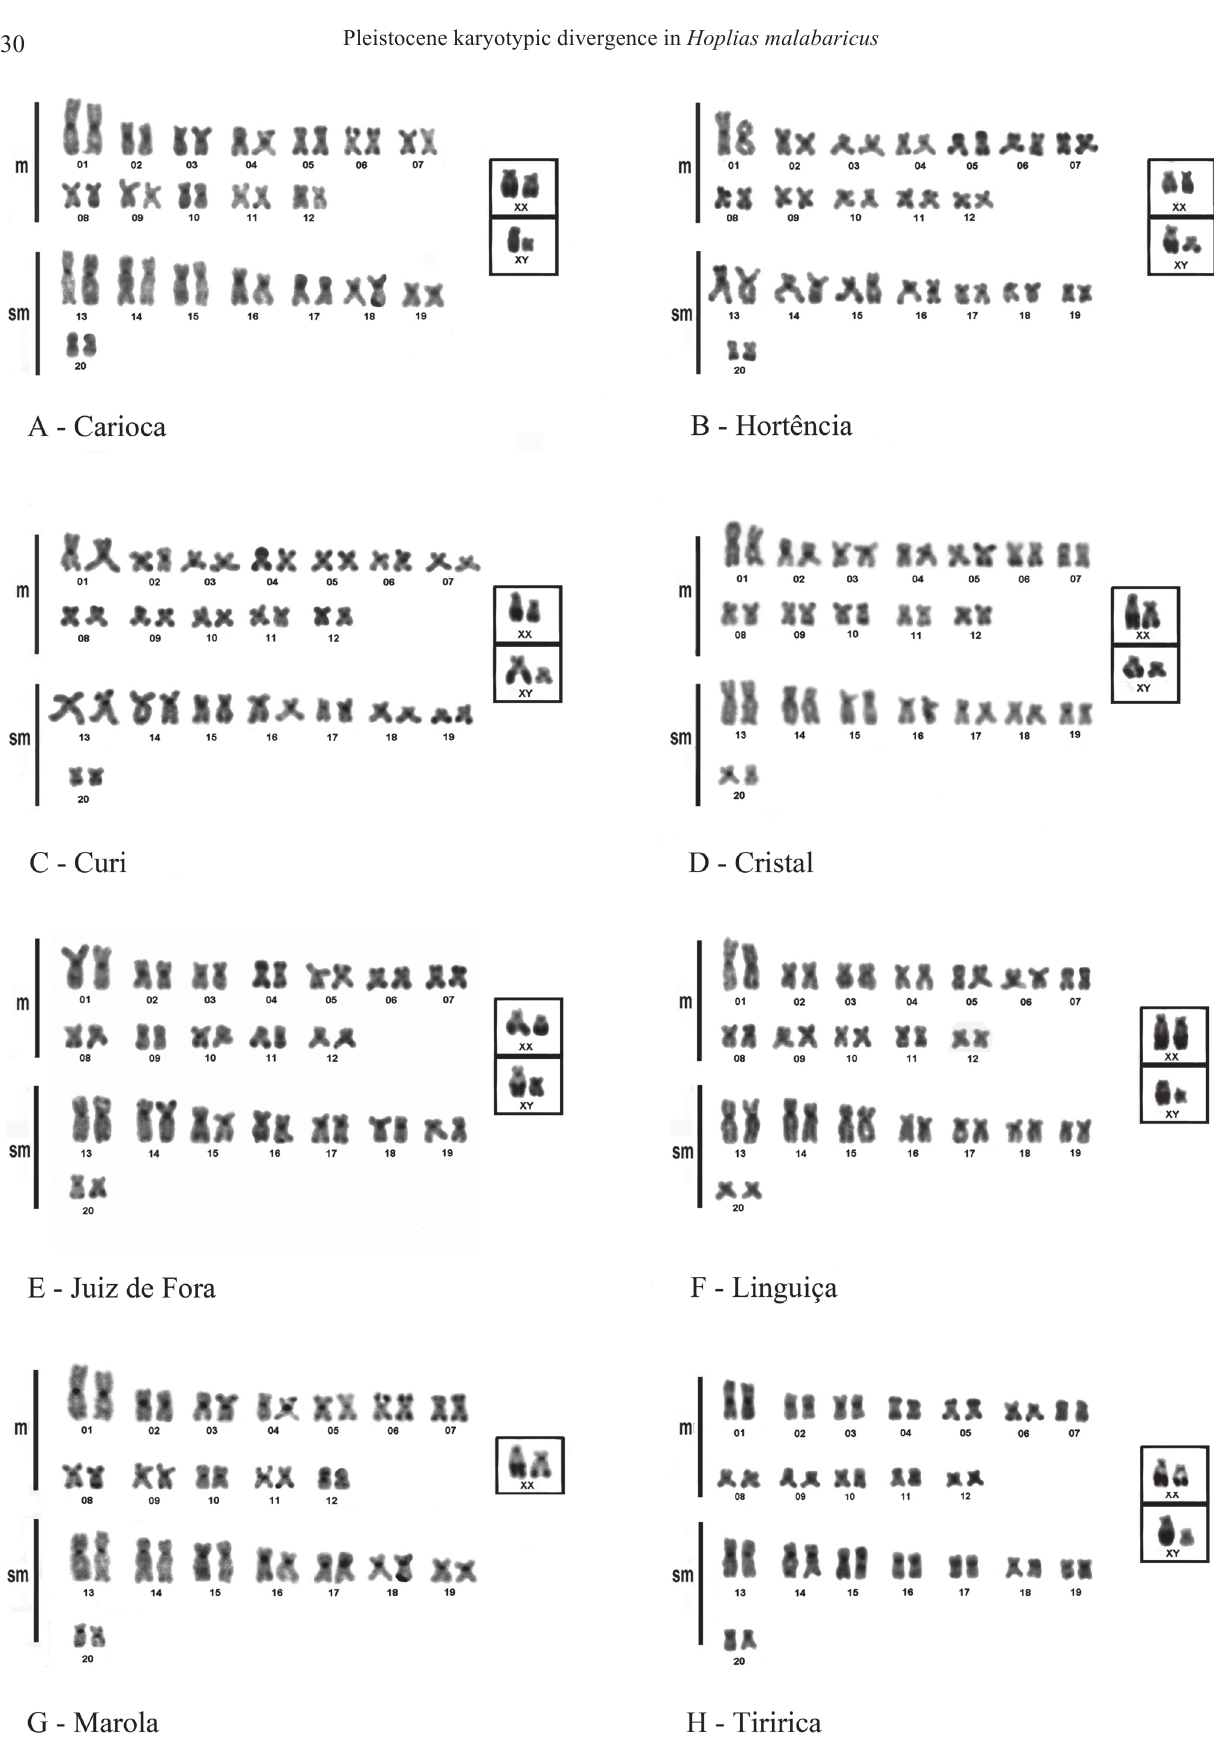
Fig. 5. C-banding patterns of H . malabaricus populations. Lake names are